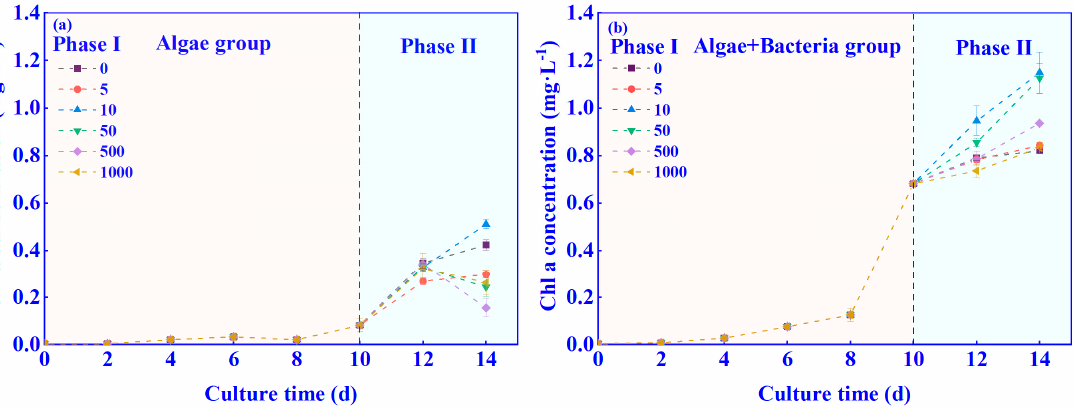
Figure 2. E ff ect of di ff erent concentrations C 6 -HSL on Chl-a concentration in ( a ) algae group and ( b ) algae–bacteria group. Numbers mean the concentration of C 6 -HSL (ng/L). Phase I is without the addition of C 6 -HSL, and Phase II is with the addition of C 6 -HSL.